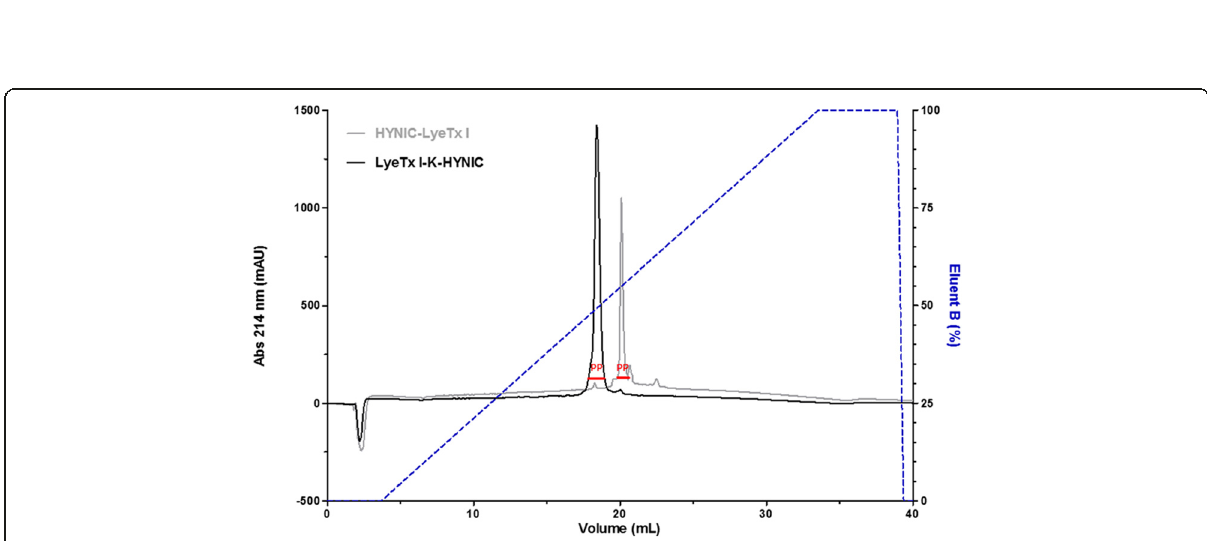
Fig. 3 Purity assessment of synthetic purified peptide LyeTx I derivatives modified with the chelating agent HYNIC, by RP-HPLC (Ettan LC, GE HealthCare, USA). Chromatograms of synthetic purified HYNIC-LyeTx I ( gray line ) and LyeTx I-K-HYNIC ( black line ): PepMap C18 TM column (5 μ m, 150.0 mm × 4.6 mm) equilibrated with 0.1 % (v:v) TFA in water (eluent A) and eluted by a linear gradient of 0.1 % (v:v) TFA in acetonitrile (eluent B); the flow was 1.0 mL . min − 1 and the detection was at 214 nm. PP: peak of